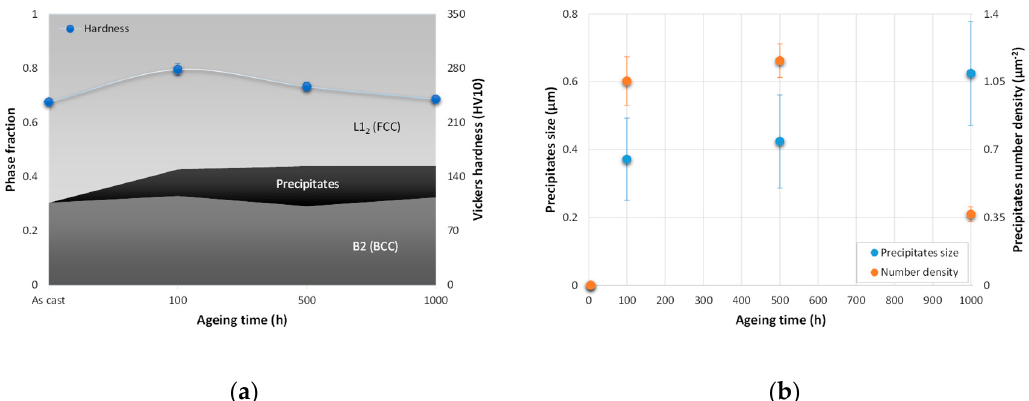
Figure 5. Microstructure evolution and hardness change as a function of aging at 800 ◦ C: ( a ) Phase fractions and Vickers hardness; ( b ) Precipitates size and their number